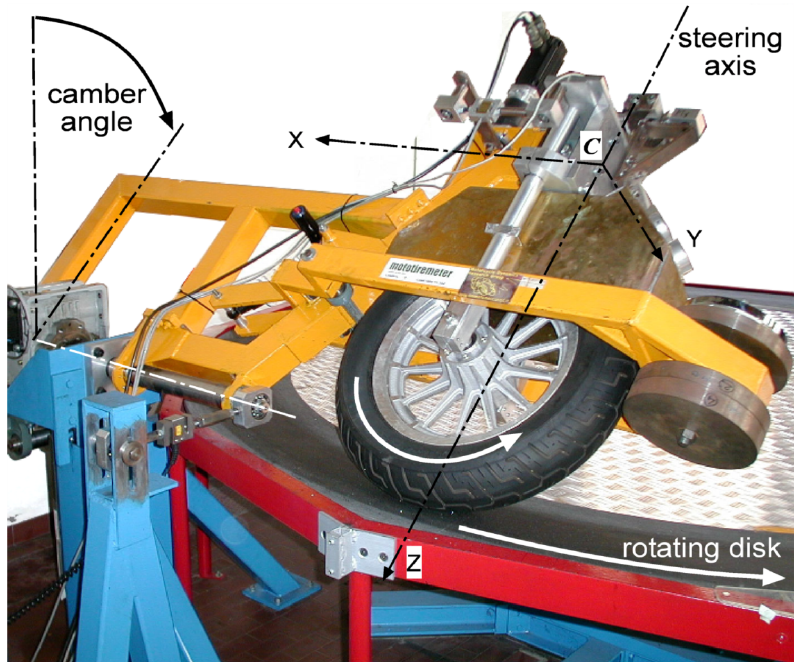
Figure 1. Tyre test rig layout. The tyre rolls freely on the rotating disk and is held in position by an articulated structure. The whole structure can camber with respect to the ground. The front assembly—which holds the wheel in place—can steer with respect to the cambered structure. Steel disks sets the vertical